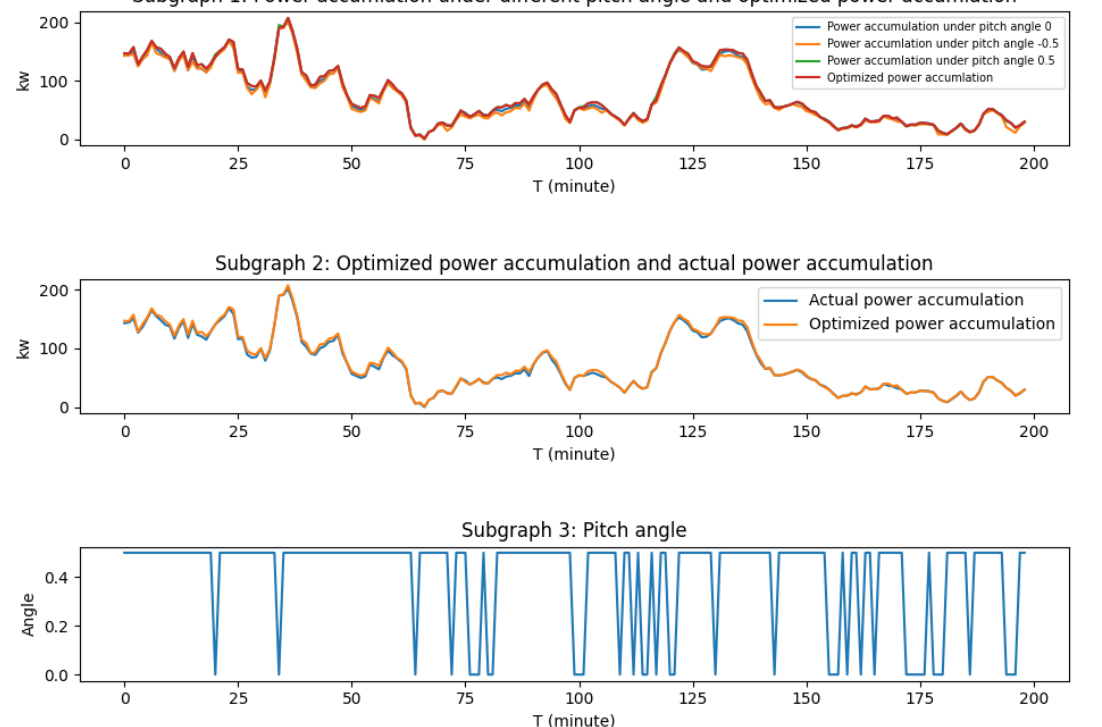
Table 8. Power optimization on #70 under different period.